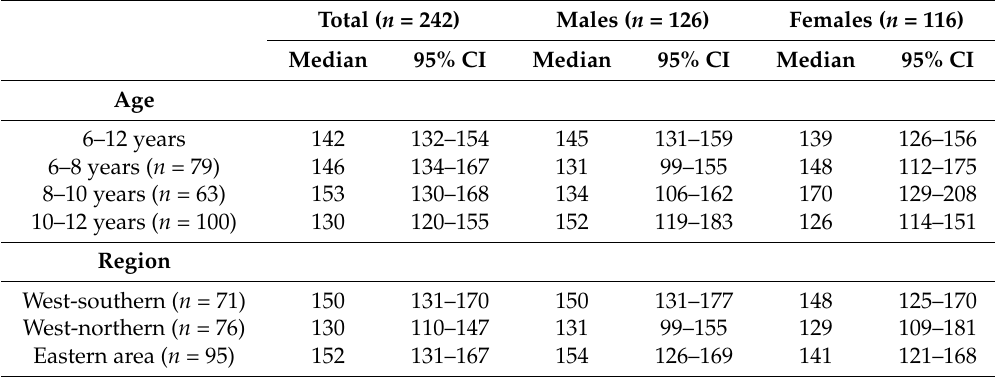
Table 1. Urinary iodine levels ( µ g/L) by age, gender, and geographic area. Total ( n =